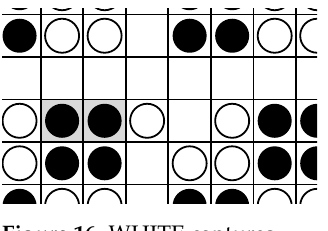
Figure 15. Corner’s WHITE moves vertically.